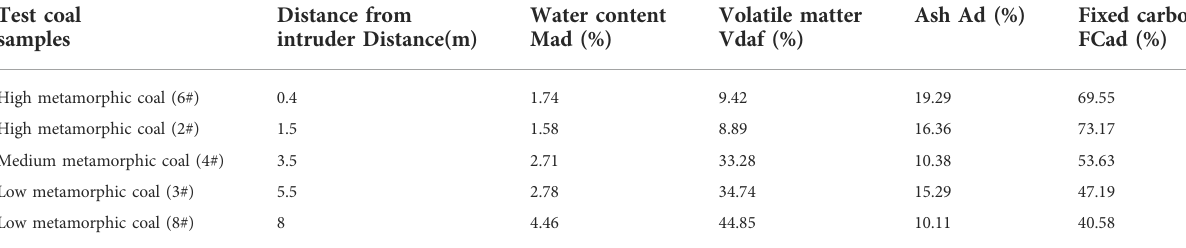
TABLE 1 Industrial analysis of coal